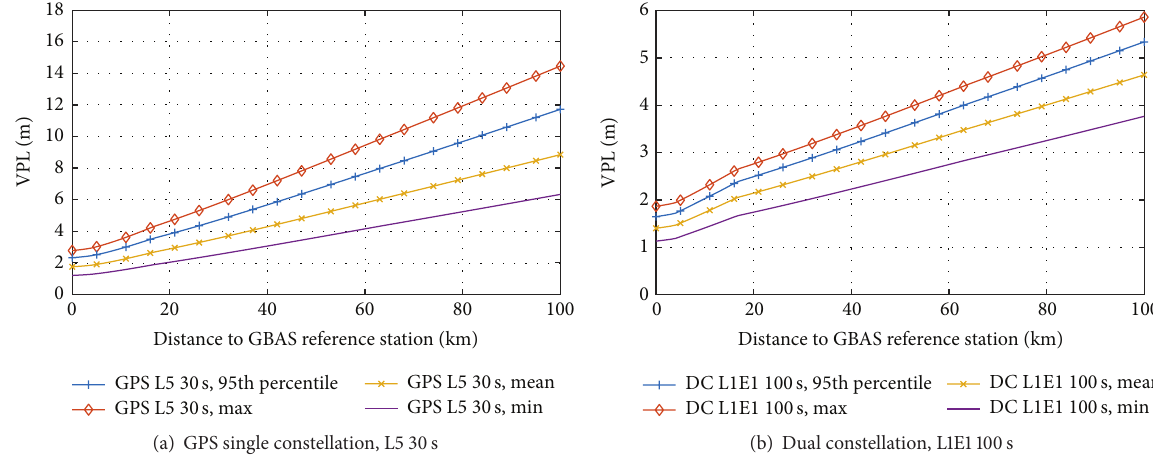
Figure 11: Comparison of minimum, maximum, mean, and 95 th percentile of H0 VPL over distance during 10 days of simulation.